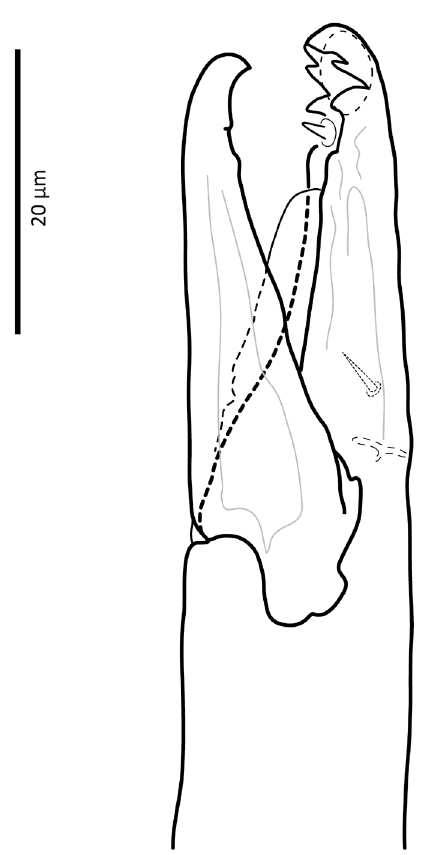
Figure 8. Zygoseius papaver sp. n., female, chelicera, ventro-paraxial view.